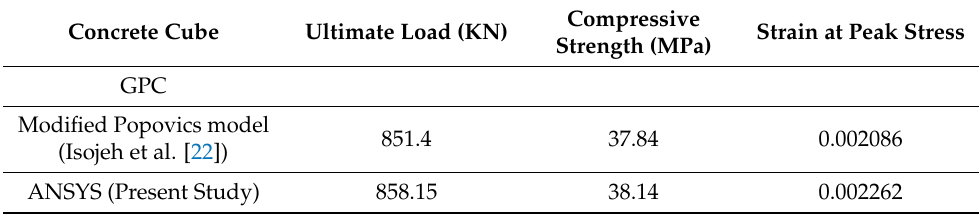
Table 3. Comparison of numerical results in the present study and the modified Popovics Table 2. Concrete failure criteria constants in ANSYS (William–Warnke).